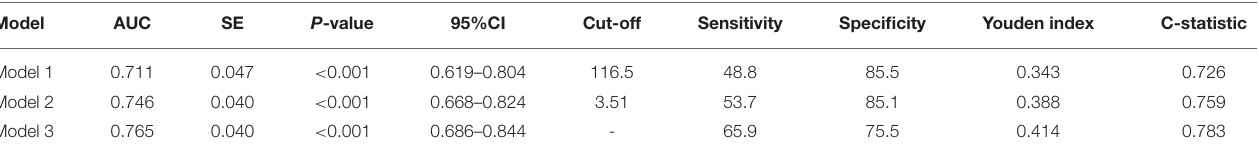
TABLE 7 | ROC analysis comparing the predictive efficacies of related variables for the incidence of MACEs during follow up. Model AUC SE P -value 95%CI